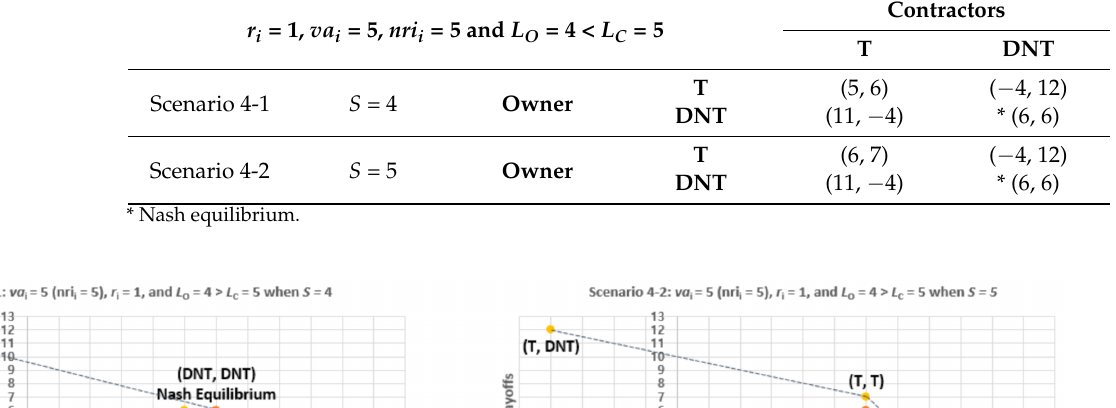
Table 9. Payoff matrix of Scenario 3.